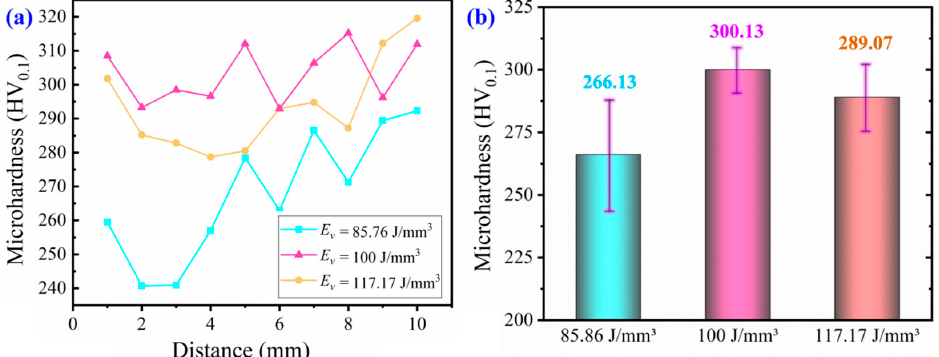
Figure 9. Vickers hardness in the X–Z plane of SLMed IN718 samples with different laser volume energy densities: ( a ) hardness distribution and ( b ) average hardness value.